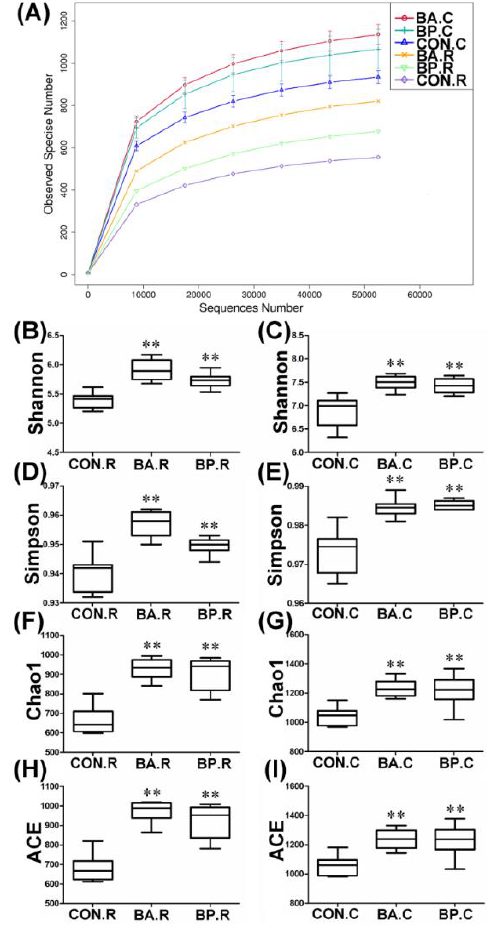
Figure 2. Rarefaction curve and boxplot of differences in bacterial community richness and diversity. ( A ) Rarefaction curve, ( B ) and ( C ) Shannon index, ( D ) and ( E ) Simpson index, ( F ) and ( G ) Chao1 index, and ( H ) and ( I ) ACE (Abundance-based Coverage Estimator) index. BA.R, BP.R, and CON.R indicate rumen content samples of BA-treated, BP-treated, and control groups, respectively; BA.C, BP.C, and CON.C indicate caecum feces samples of BA-treated, BP-treated, and control groups, respectively. ** p < 0.01, compared with the control group.